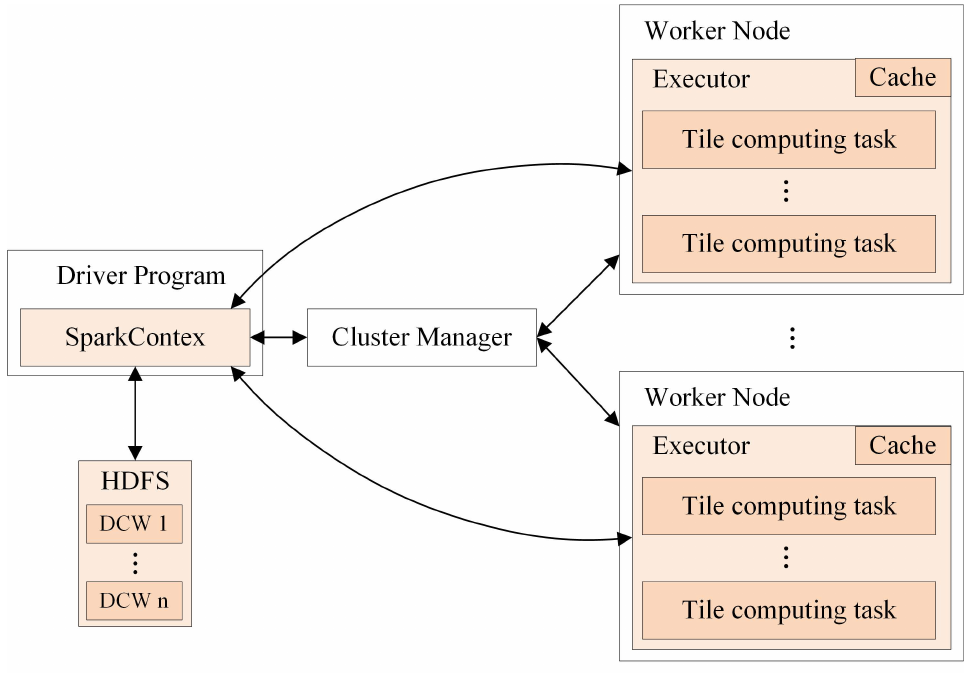
Figure 10. The dynamic calculation window (DCW) computing strategy in Spark. More details of the Spark-based slope algorithm are described in Algorithm 1. index denotes the index of each grid cell of a tile, value denotes the elevation of the cell, TileNo denotes the serial number of the tile, TilePath denotes the tile path in the HDFS, and TileColNum denotes the number of columns of